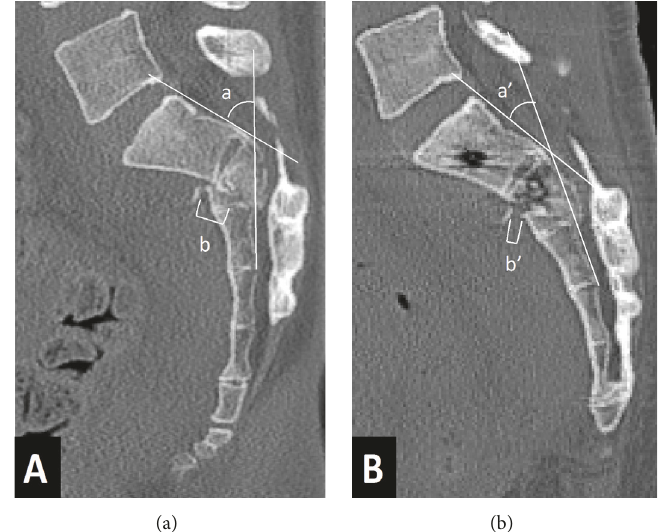
Figure 2: Radiological measurement methods. (a) A preoperative CT scan of the sacrum in the sagittal plane is shown. (b) A postoperative CT scan of the sacrum in the sagittal plane is shown. a and a’: sacral kyphotic angle; b and b’: sacral fracture